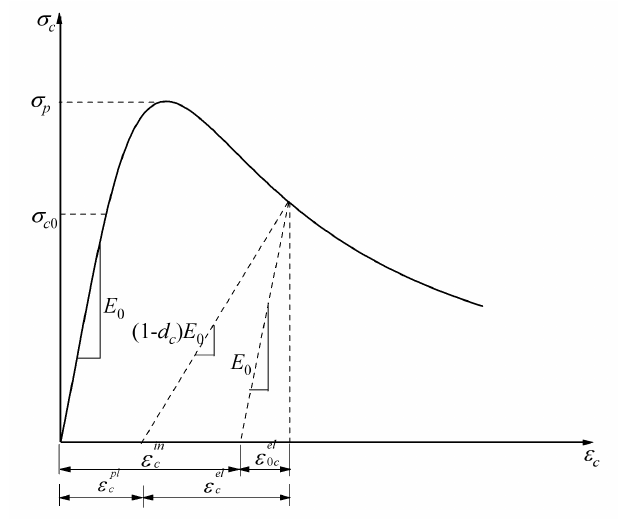
Figure 12. Response of concrete to uniaxial loading in compression.